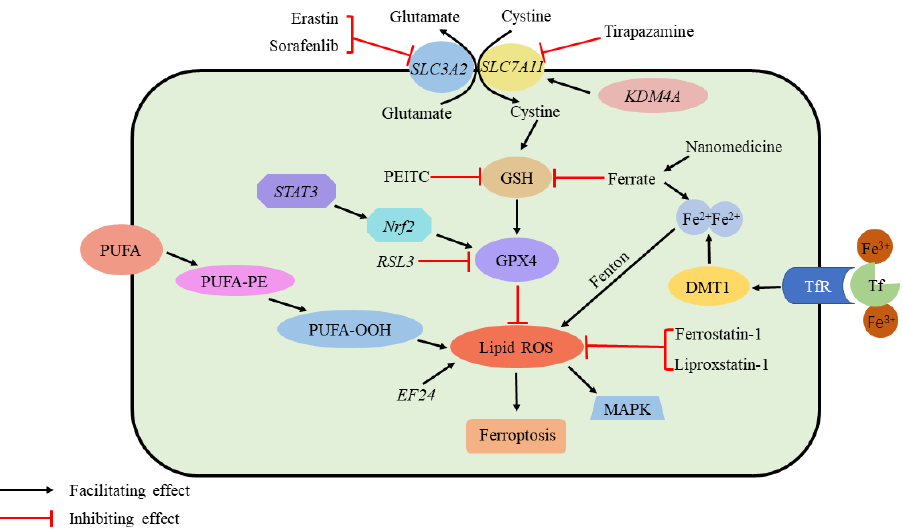
Figure 4. Ferroptosis and osteosarcoma. Ferroptosis requires ROS accumulation. The production of ROS is initiated by the peroxidation of unsaturated fatty acids and iron catalysis. In addition, several elements regulate the GPX4 pathway, which is critical for inhibiting ferroptosis by scavenging ROS: Sorafenib and erastin inhibit cystine transport via System Xc-. As a result of PEITC, GSH level is depleted; ferrate increases iron content as well as depleting GSH. As a result of Tirapazamine, SLC7A11 is suppressed. STAT3/Nrf2 facilitates GPX4 production, while RSL3 inhibits it. While EF24 promotes ROS formation, Ferrostatin-1 and Liproxstatin-1 suppress it. KDMA4 promotes cystine transit by demethylating SLC7A11 . Nanomedicine Accumulates Fe 2+ and consumes GSH. ROS, reactive oxygen species; PEITC, b-phenethyl isothiocyanate; STAT3 , signal transducer and activator of transcription 3; Nrf2 , nuclear factor erythroid 2-related factor 2. EF24 , 3,5-bis (2-fluorobenzylidine)- 4-pyperidone; GPX4, glutathione peroxidase 4; KDM4A , lysine demethylase 4A; GSH, glutathione. Table 2. Ferroptosis and osteosarcoma.